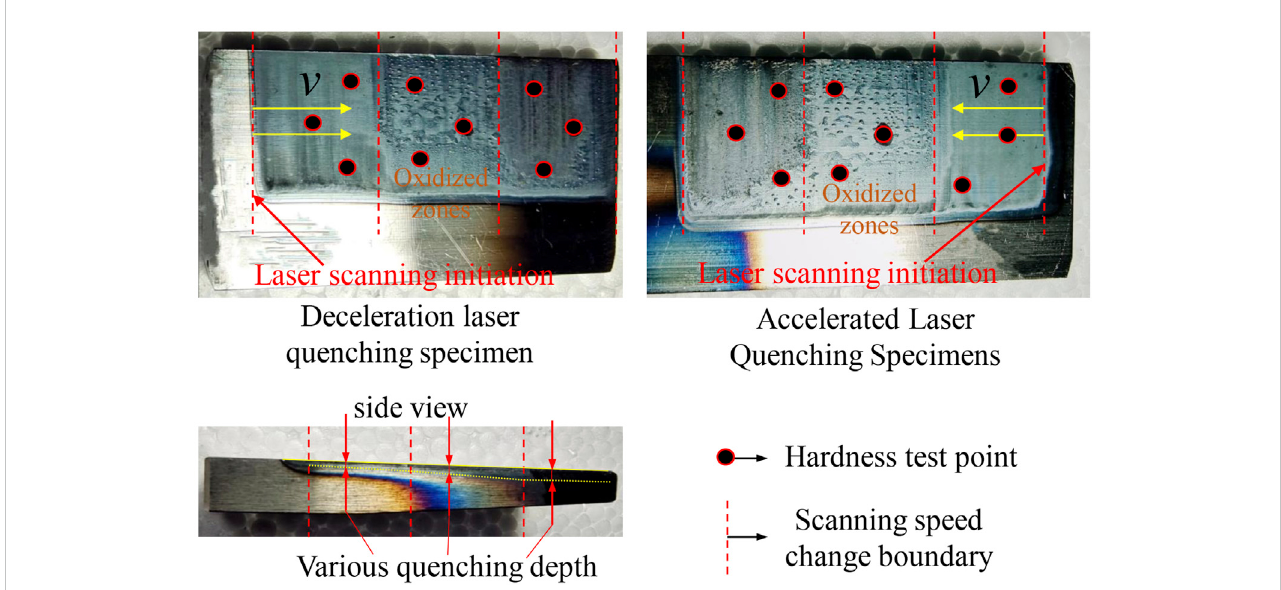
FIGURE 3 Schematic diagram of specimen morphology after accelerated and decelerated laser quenching.